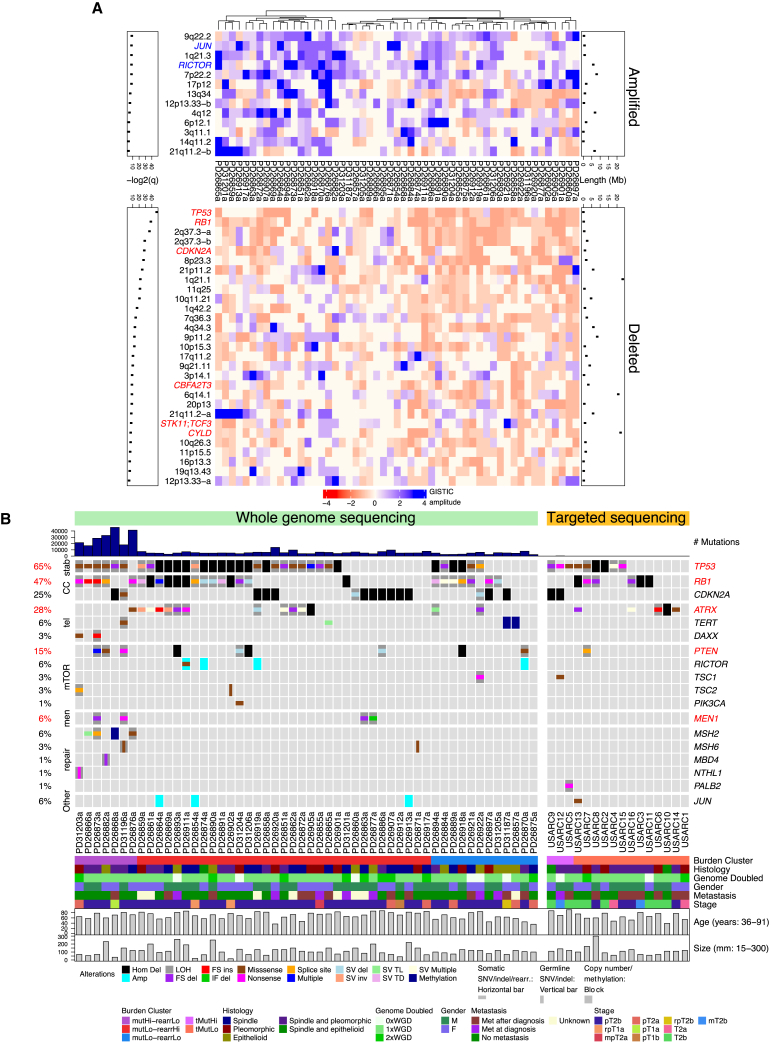
Integration of Driver Events in USARCs(A) Heatmap showing significant recurrently amplified or deleted regions (GISTIC q < 0.1). Known cancer driver genes in amplified regions are labeled in blue and those in deleted regions are labeled in red. Lengths of significant regions (Mb) are indicated above the heatmap, with –log2(q values) below.(B) SNV and indel mutational burden barplot (top) and copy-number alterations, SNVs, small indels, structural variants and promoter methylation alterations in known cancer genes (middle), with clinical and genetic covariates (bottom). Red text indicates driver genes identified by dNdSCV (q < 0.2). stab, genome stability; CC, cell cycle; tel, telomere maintenance; mTOR, mTOR signaling pathway; men, MENIN pathway; repair, DNA repair. Samples are ordered by sequencing platform, burden group, and mutational status.See also Table S2.